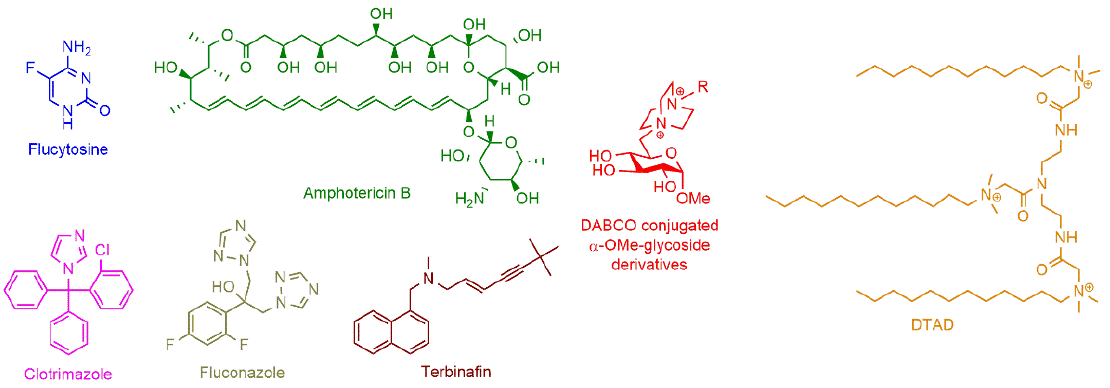
Figure 1. Structure of some antifungal drugs and antifungal cationic ammonium derivatives including carbohydrates and surfactants.